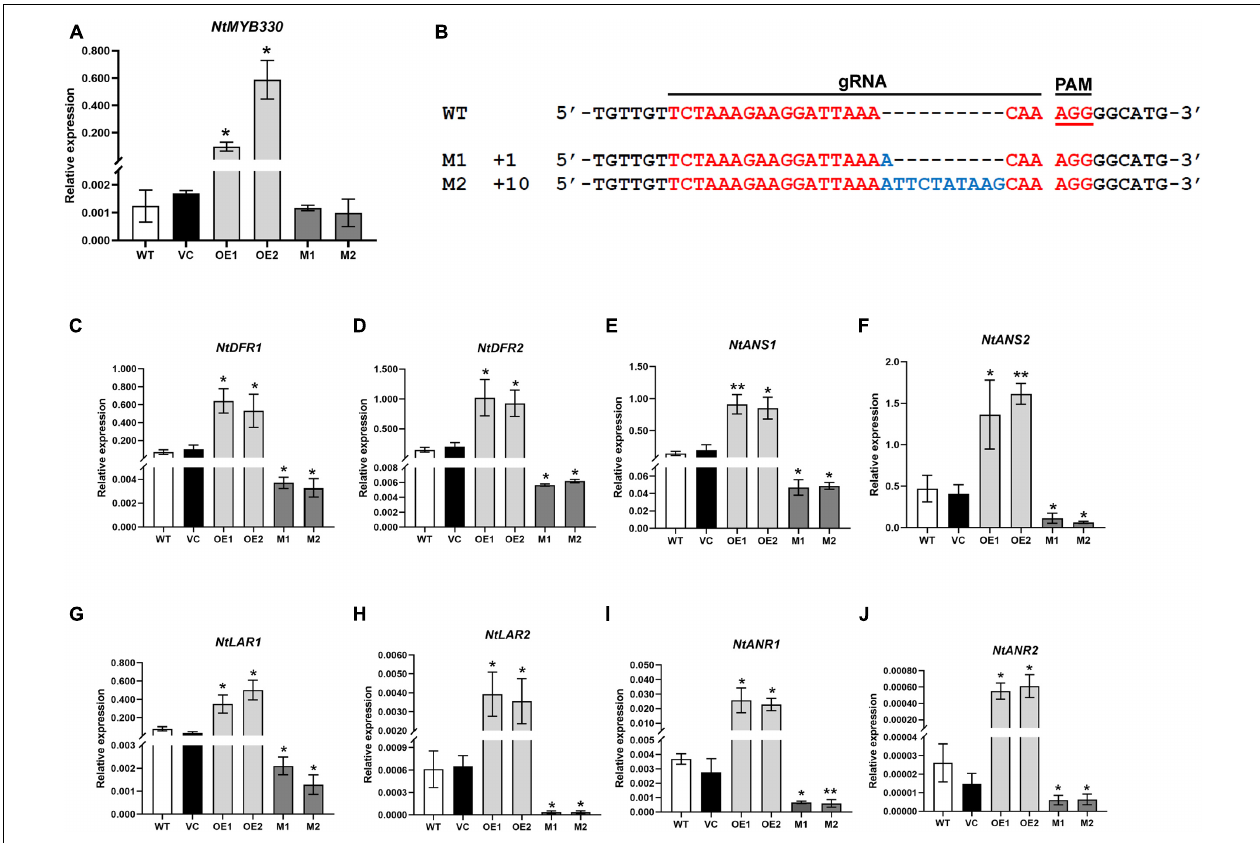
FIGURE 3 | Quantitative transcript analyses of NtMYB330 and LBGs in PA pathway in tobacco flowers. (A) Expressions of NtMYB330 in the flowers of different tobacco lines. (B) Alignment of reads with CRISPR/Cas9-induced mutagenesis in NtMYB330 . The wild-type sequence was shown at the top, and the two sequences on the bottom were reads of ntmyb330 mutant lines (M1 and M2). The targeted sequence was shown in red, while mutations were shown in blue. gRNA sequences used for genome editing and PAM (protospacer adjacent motif) are indicated. The sizes of the InDels introduced are shown on the left. Analyses of expressions of (C) NtDFR1 , (D) NtDFR2 , (E) NtANS1 , (F) NtANS2 , (G) NtLAR1 , (H) NtLAR2 , (I) NtANR1 and (J) NtANR2 in the flower petals of wild-type (WT), vector control (VC), NtMYB330-OE lines (OE) and ntmyb330 mutants (M). Data are the mean of three replicates with error bars indicating ± SD. Asterisks indicate statistically significant differences from WT according to paired t -test (* P < 0.05; ** P <